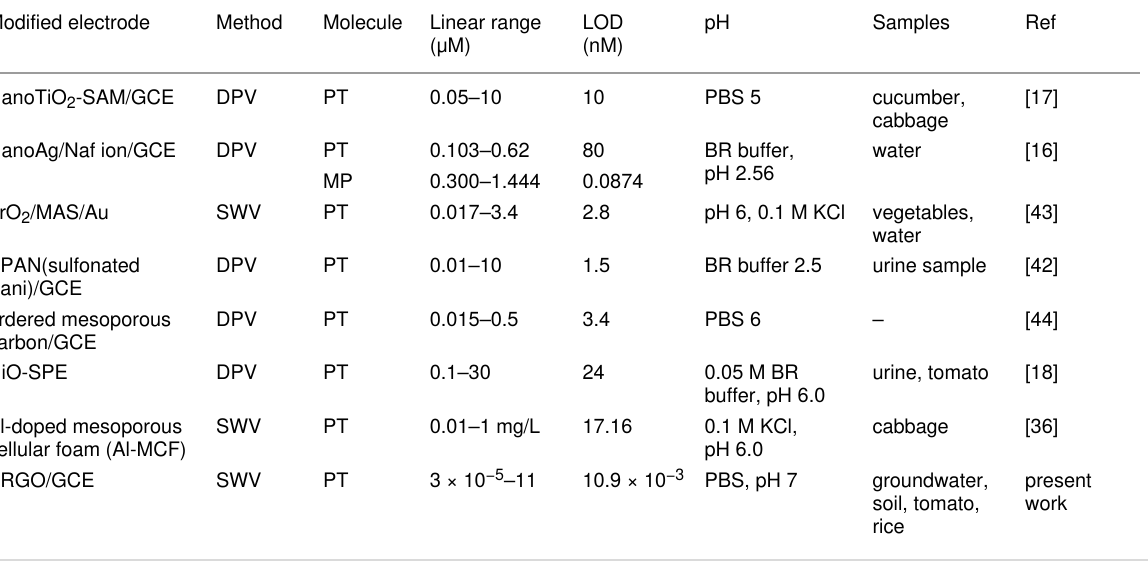
Table 2: Experimental sample table for a comparative analytical performance of the proposed nanosensor with the reported nonenzymatic nanosensor. Modified